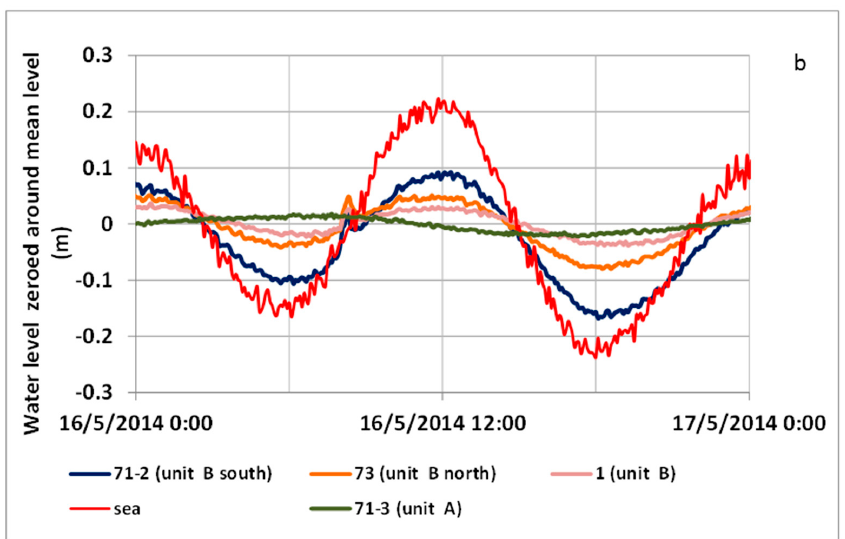
Figure 4. Detailed (5 min) water level time series in monitoring wells and the sea. ( a ) a 48 h level fluctuations; ( b ) 24 h superimposed levels of different wells and the sea, zeroed around their mean level. See well locations in Figure 1. Table 1. Maximum tidal amplitudes in different units and distance from shoreline during May 2014. Amplitude (cm) Distance from Shoreline (m) Aquifer Unit Well Name